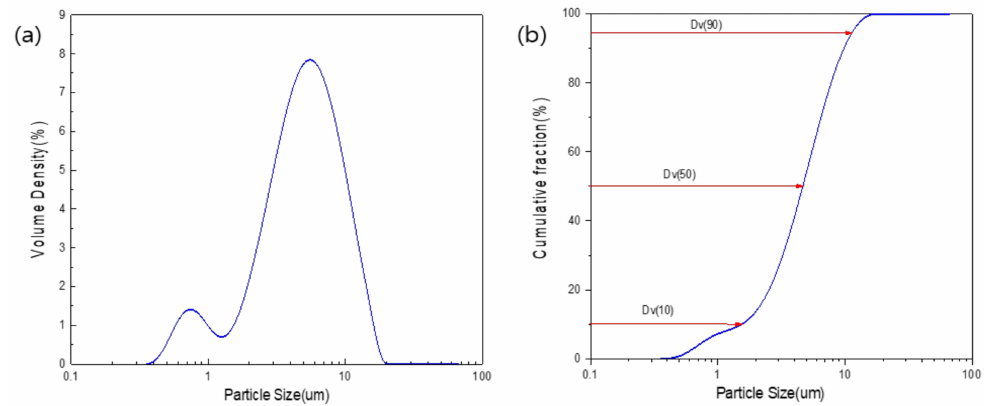
Figure 3. Particle size distribution in bio-sulfur. Dv is volume-average diameter. ( a , b ) is shows each the distribution and the cumulative distribution of particle size. The graph indicates that the area under 10 um occupies 90% of the total size distribution.